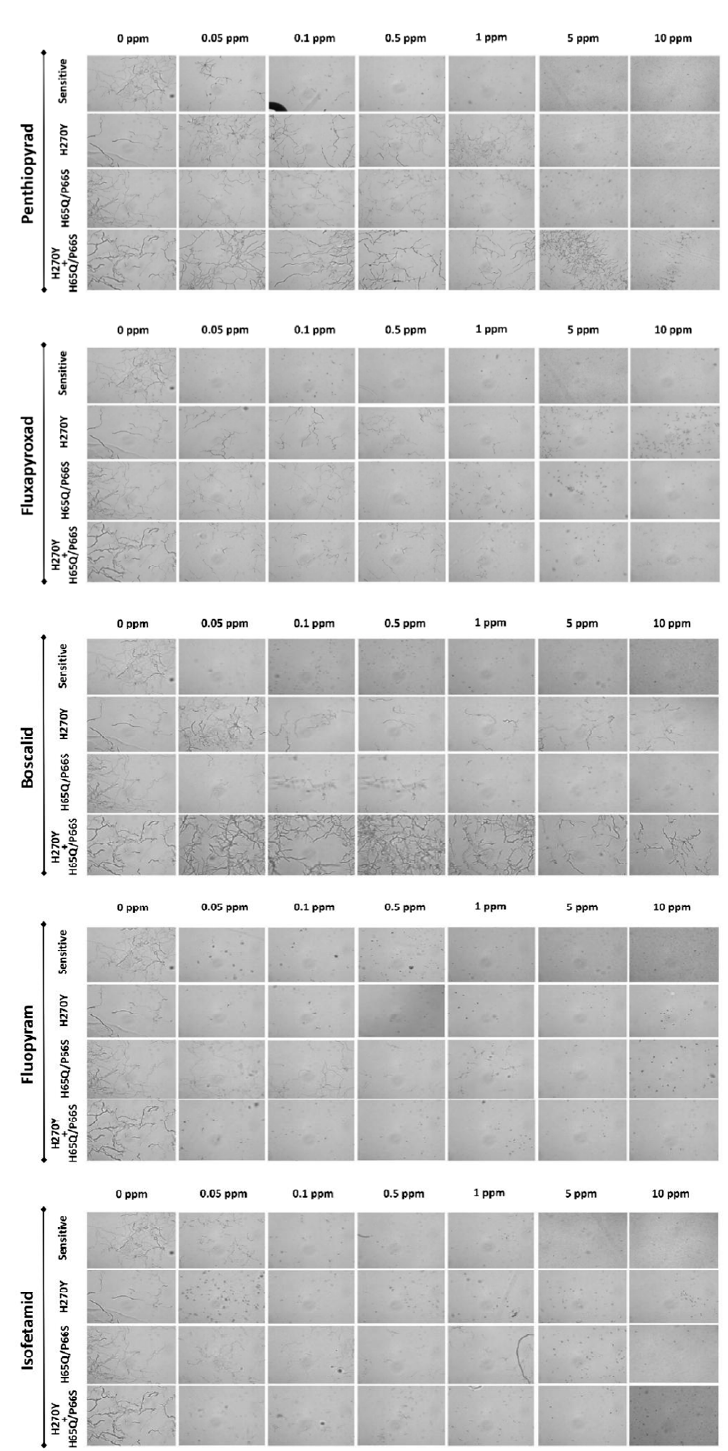
Figure 6. Germ tube growth of the Aspergillus uvarum isolates (A60-sensitive; A137—H270Y; A121- H65Q/P66S; B12—H270Y+H65Q/P66S) grown on nutrient media amended with several concentra- tions of the SDHI fungicides boscalid, fluopyram, isofetamid, penthiopyrad, and fluxapyroxad. All of the isolates possessing the H270Y mutation were either moderately- or highly- resistant to fluxapyroxad, boscalid, and penthiopyrad, with RF values ranging from 50.5 to 208, 195 to 298, and 20.7 to 174, respectively. In contrast, none of the H270Y mutants were resistant to either isofetamid or fluopyram. The double mutation identified in